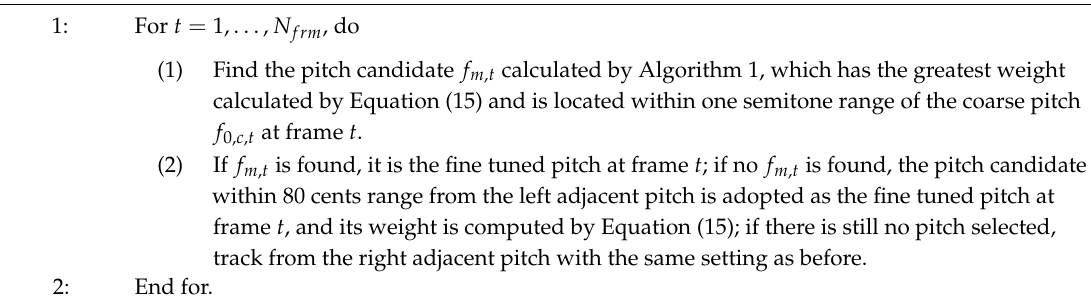
Algorithm 2. Melodic pitch fine